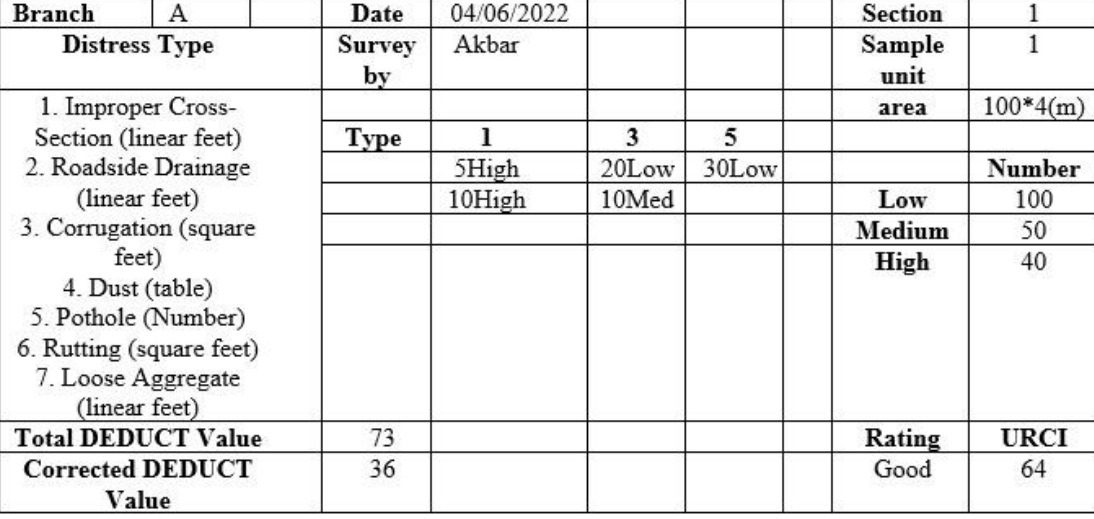
Figure 1. URCI survey